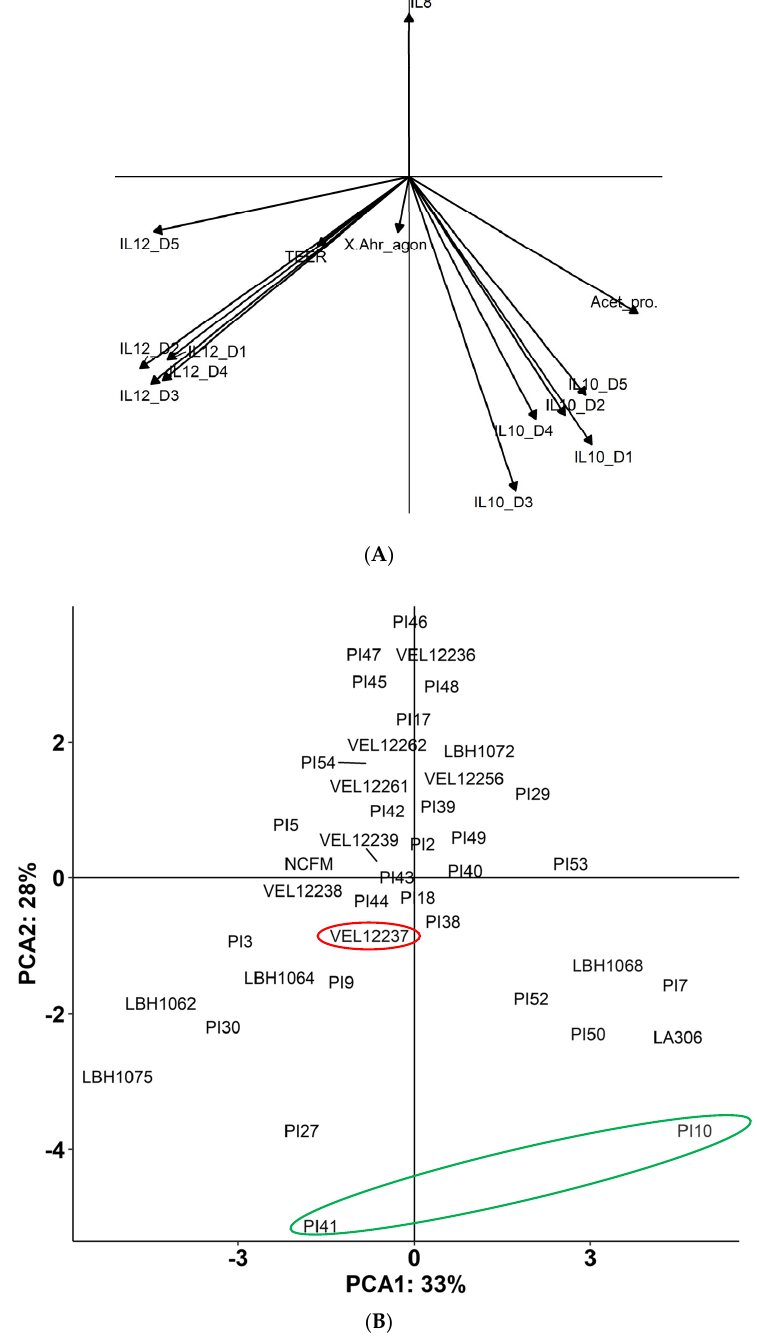
Figure 7. ( A ) Correlation circle and ( B ) PCA. The two axes represent 61% (28 + 33) of the total inertia. The strains circled in green (PI41 and PI10) were chosen for in vivo tests. The strain VEL12237 circled in red was selected as the negative/neutral control.